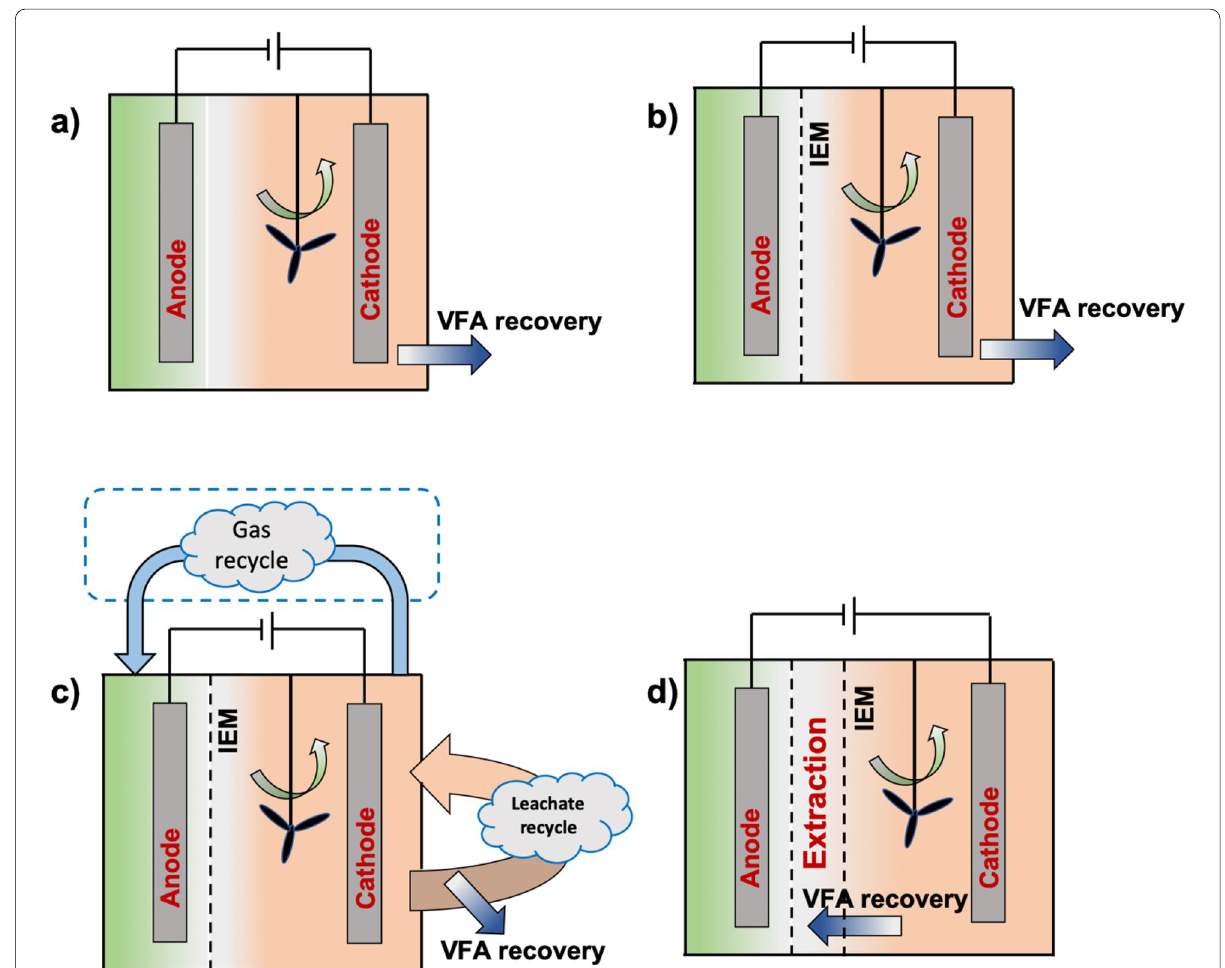
Fig. 4 Possible electrochemical fermentation reactors: a single chamber without membrane separation; b membrane‑separated chambers; c reactor with off‑gas recycle, and d reactor with membrane extraction chamber (IEM: ion exchange